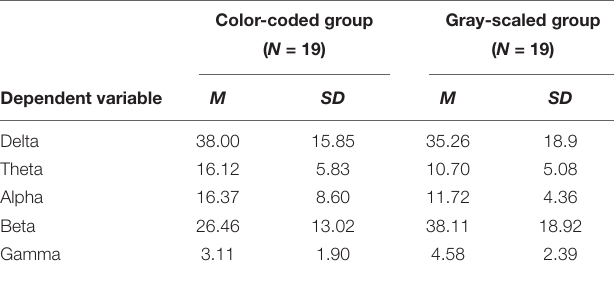
TABLE 4 | Means and standard deviations of EEG power